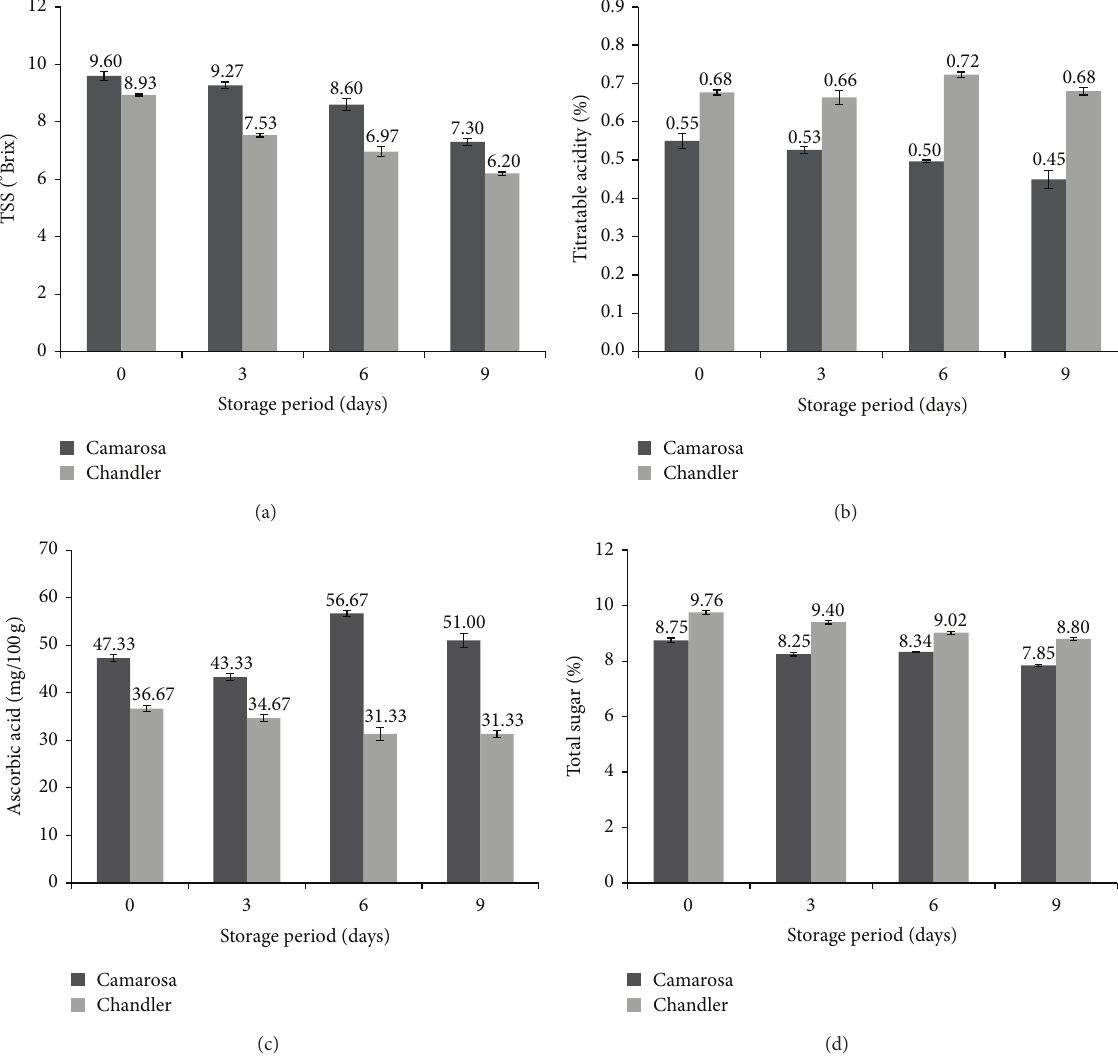
Figure 1: Changes in physicochemical parameters of strawberries during storage at 5 ∘ C (a) TSS, (b) titratable acidity, (c) ascorbic acid, and (d) total